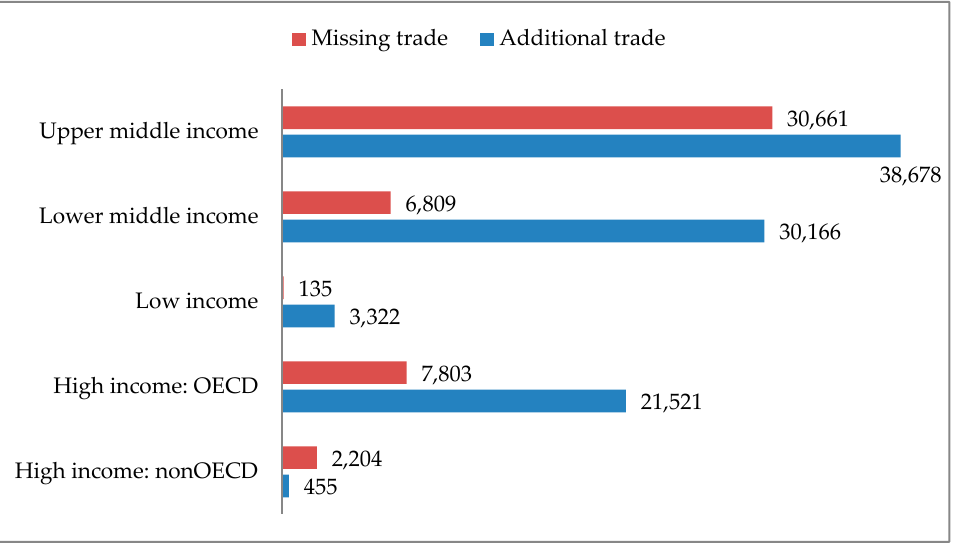
Figure 4. Trade effect due to preference: Results by countries based on income levels (CES reference tariff). At world prices; millions of €. Source : Elaboration on data by COMEXT and TRAINS; 2017.